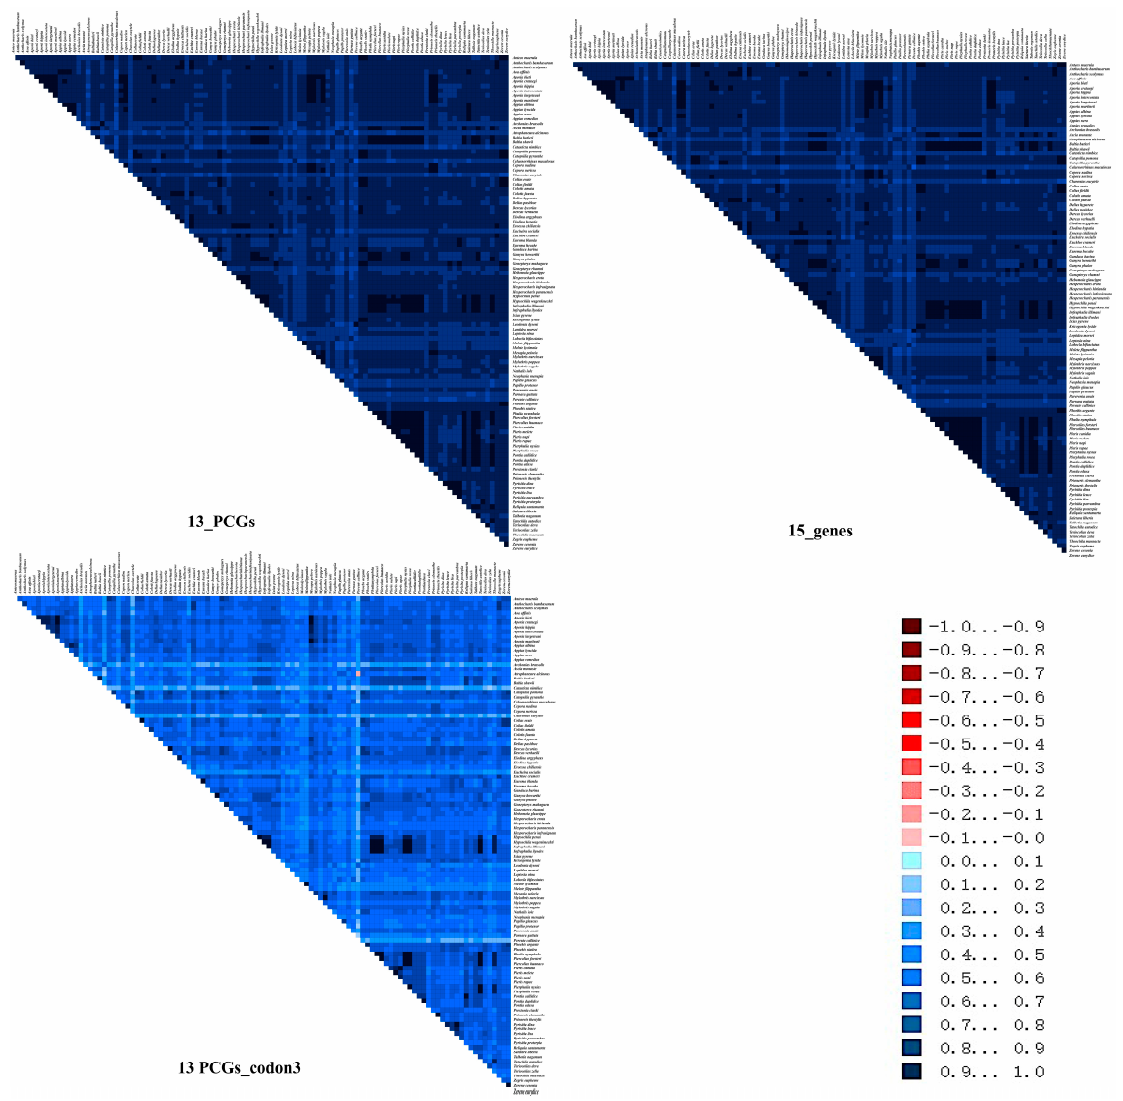
Figure 5. Heterogeneous sequence divergence of mitochondrial genomes for different datasets. The mean similarity score between sequences is represented by a colored square. The scores range from − 1, indicating full random similarity, to +1, indicating non-random similarity, which is visualized by a color range from dark red ( − 1) to dark blue